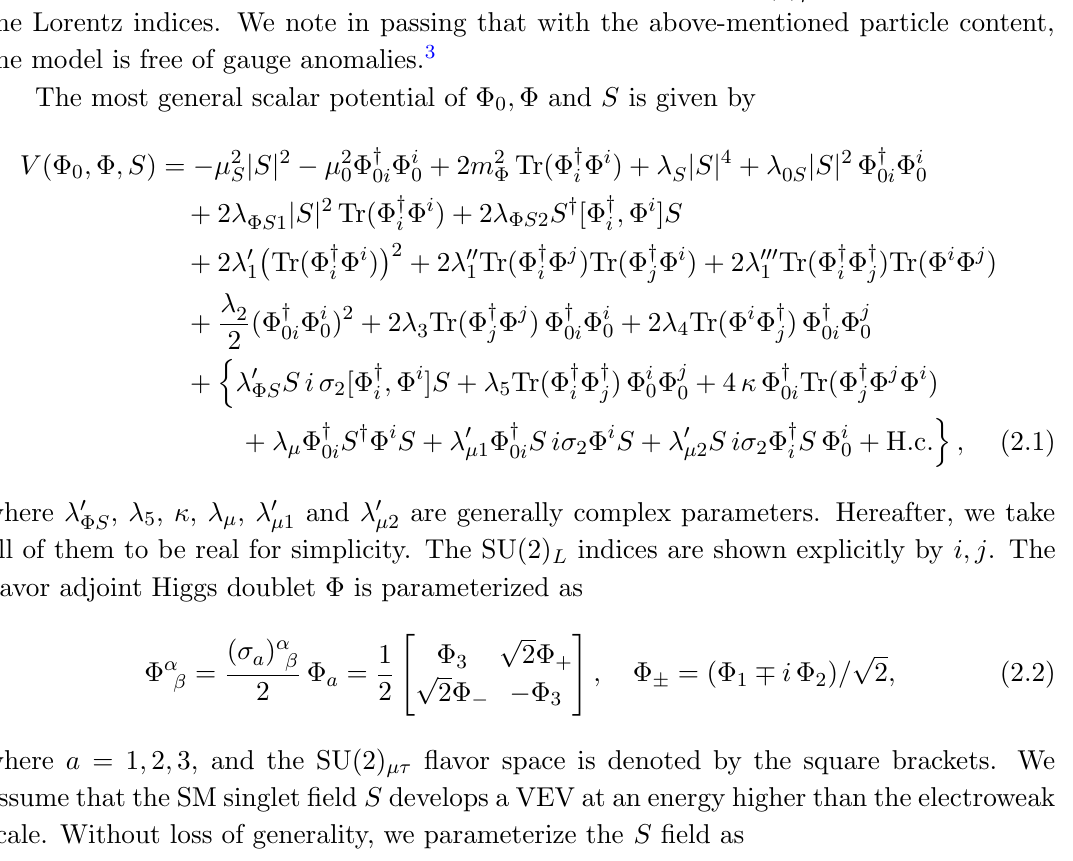
and the others for (cid:22)(cid:28)